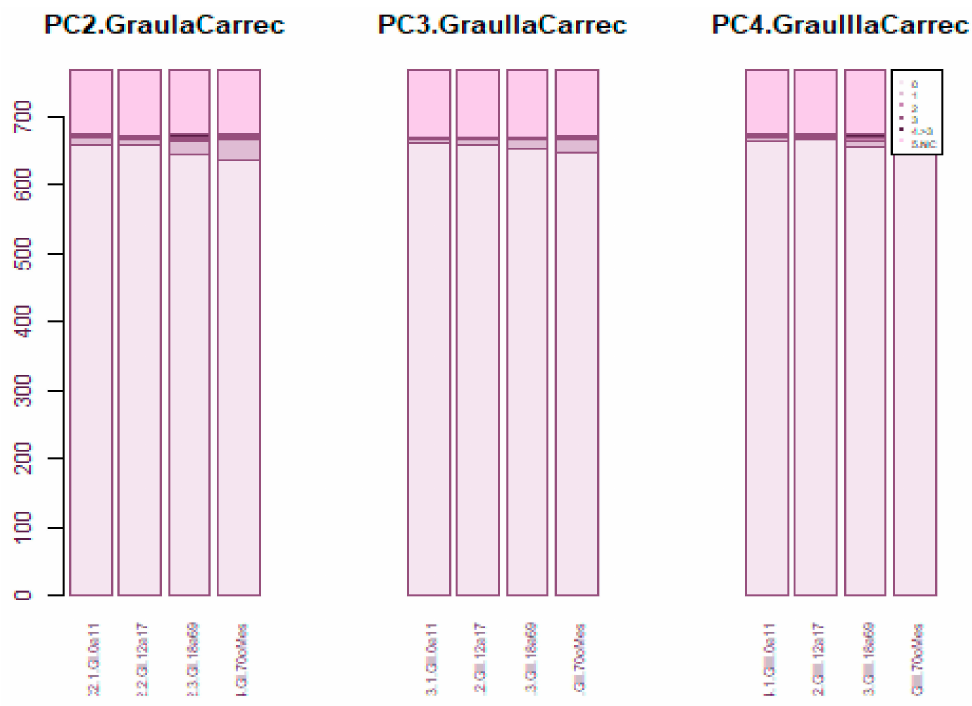
Figure 27. Multiple stacked bar plot of Question PC2-3-4. Dependent people in charge. For each degree of severity, the inner analysis replicates the structure of the previous questionSee multiple barplot of question PC2 with the number of degree I dependent people in charge per age group Figure 28.